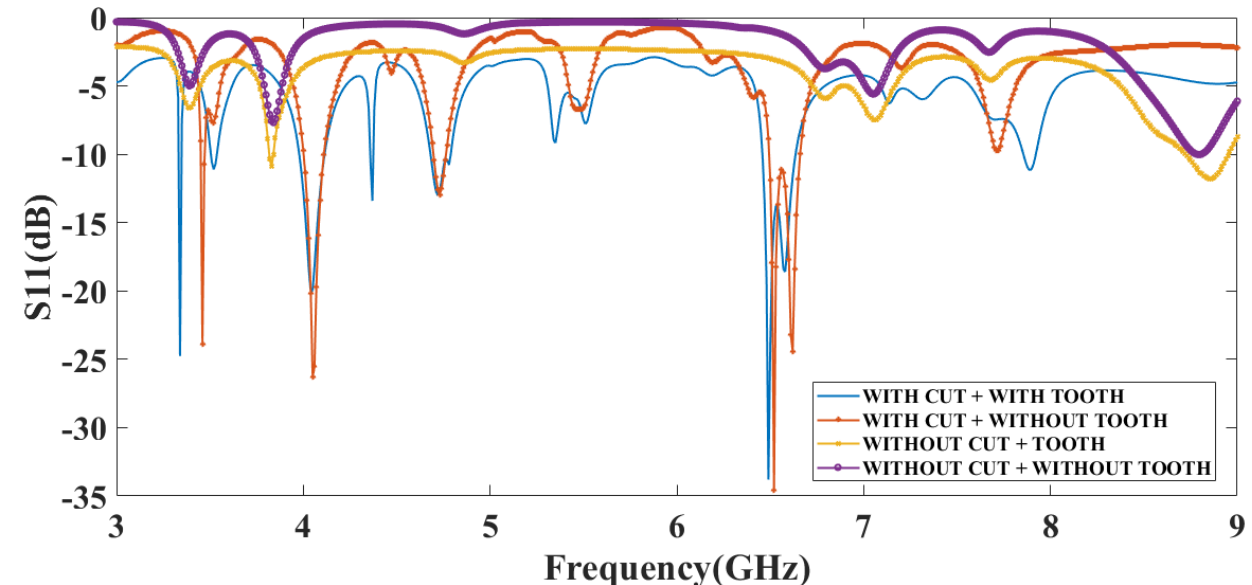
Figure 7. Simulated reflectance response analysis using Rogers RT Duroid as substrate. S 11 plot for the proposed four antenna structures for the substrate Rogers RT Duroid 5880. The number of bands for the proposed four structures is 7, 6, 3 and 1. Minimum reflectance responses are, respectively, − 33.79 dB, − 34.54 dB, − 13.79 dB and − 10.05 dB. The resonance frequency is 6.49 GHz, 6.52 GHz, 8.83 GHz and 8.80 GHz, respectively. Table 2. Reflectance plot ( S 11 ), total bands, resonance frequency, VSWR, and bandwidth data repre- sentation for the proposed four antenna structures using a substrate of Rogers RT Duroid